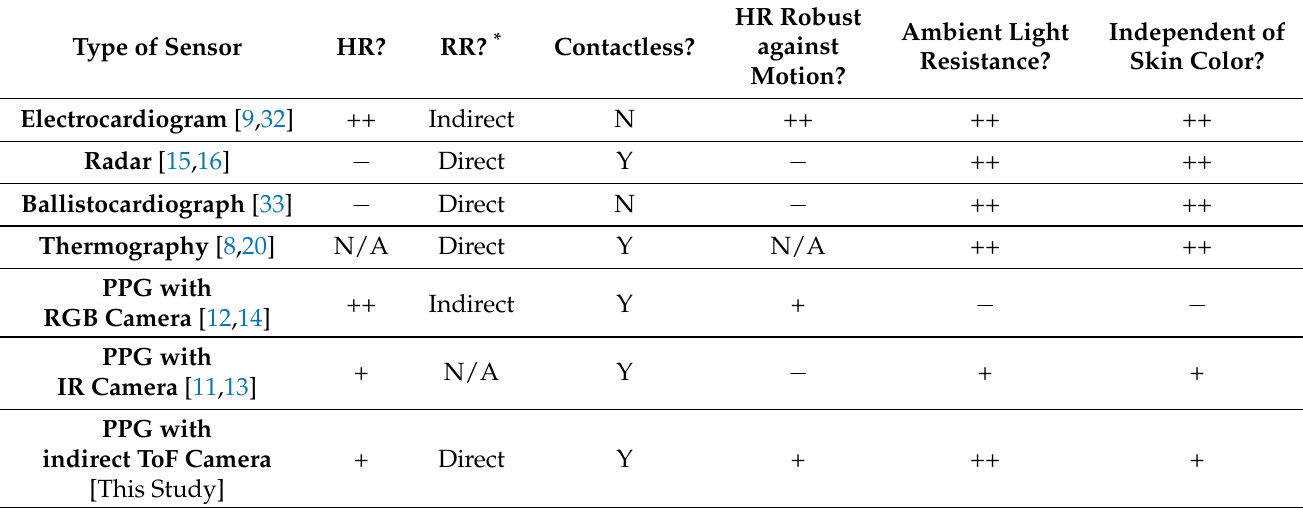
Table 1. Summary of HR/RR measurement techniques used in